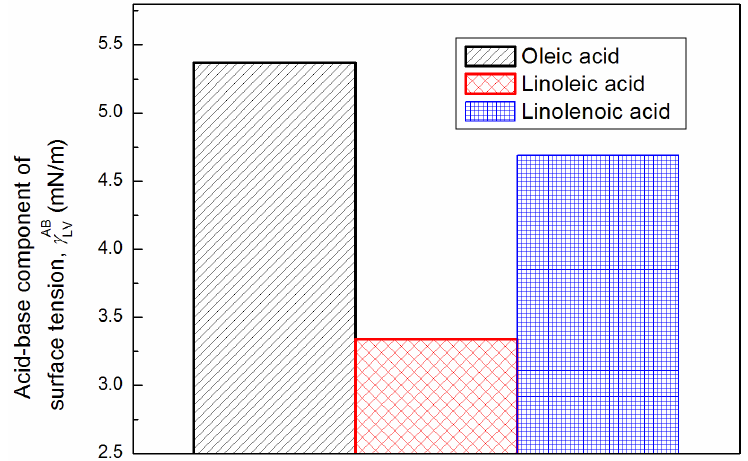
AB  ) of oleic, linoleic, and linolenic acids’ surface LV